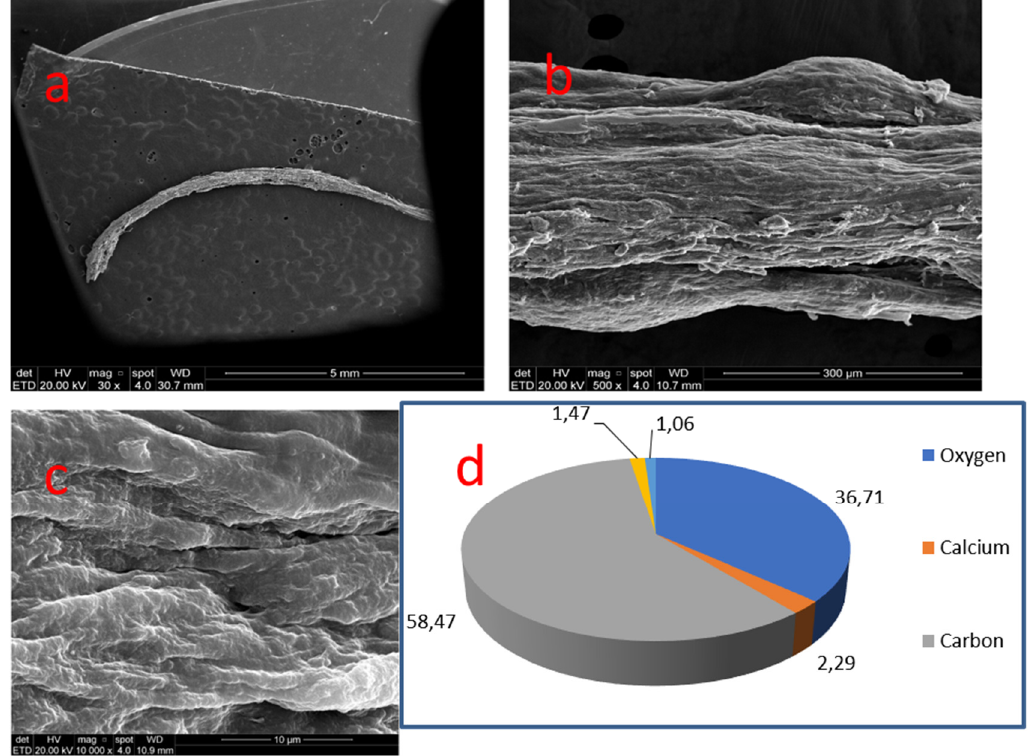
Figure 9. Sample 07: ( a ) Radicular pulp nodule with fillet-like morphology (SEM, 30 × ); ( b ) Sur- face with sulcus and sinuous tract (SEM, 500 × ); ( c ) Fusing coronal pattern with deep indentations (MEV, 10,000 × ); ( d ) Results of chemical analysis of the sample with X-ray dispersive energy spec- troscopy